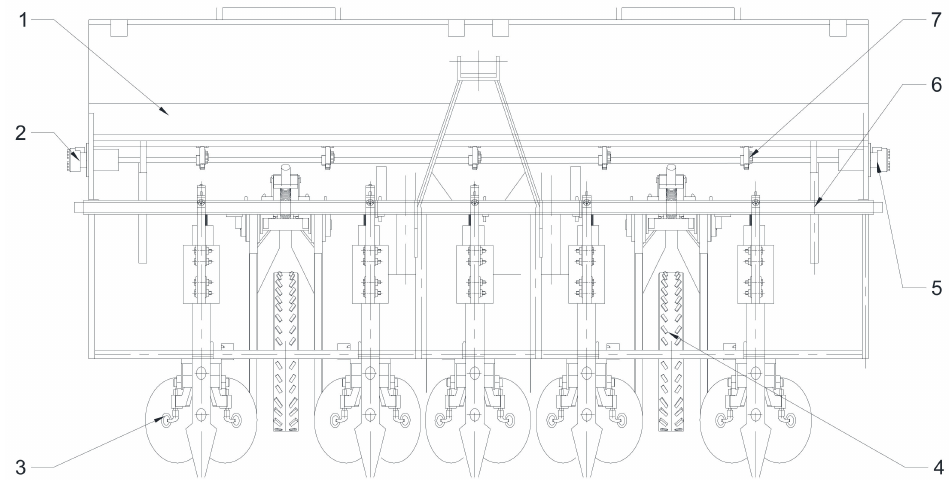
Figure 8. Structure of variable rate fertilization mechanism. 1: Fertilizer bin; 2: Opening motor; 3: Trenching and earth covering device; 4: Profiling wheel structure; 5: Speed motor; 6: Rack; 7: Fertilizer discharging